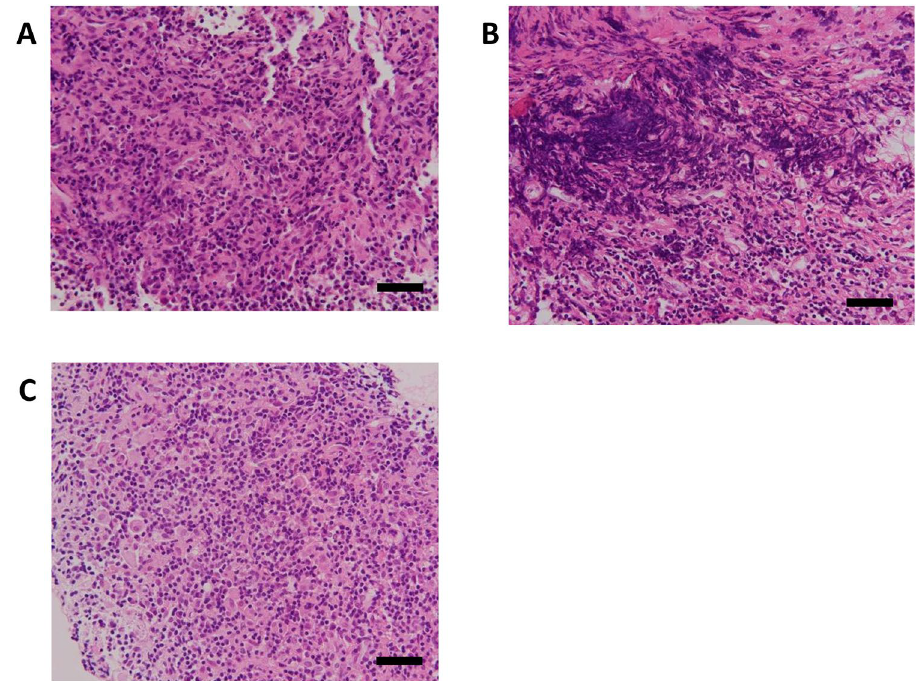
Figure 2. Microphotographs from Cases 6, 10 and 12 of the pituitary tissues stained with hematoxylin and eosin. ( A ) Microphotographs from Case 6 demonstrating lymphocytic infiltration in the posterior pituitary. ( B ) Microphotograph from Case 10 demonstrating fibrotic and lymphocytic infiltration in pituitary tissue. ( C ) Microphotograph from Case 12 demonstrating infiltration of large histiocytes and small lymphocytes in pituitary tissue. Scale bars indicate 50 μm.